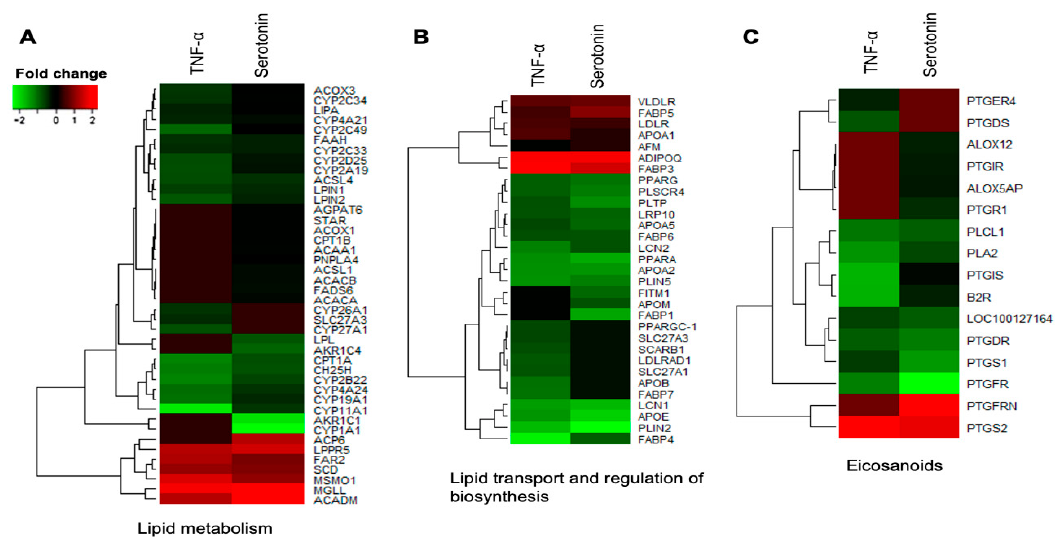
Figure 5. Genes associated with metabolic and endocrine functions which were di ff erentially expressed in porcine mature adipocytes (pMA) of intramuscular origin after in vitro stimulation with serotonin (100 µ M) and TNF- α (2.5 µ g / mL) both for 12 h. Genes are presented as di ff erent functional groups: A . Lipid metabolism, B . Lipid transport and regulation of biosynthesis, and C . Eicosanoids. Green color indicates down-regulation and red color for up-regulation.